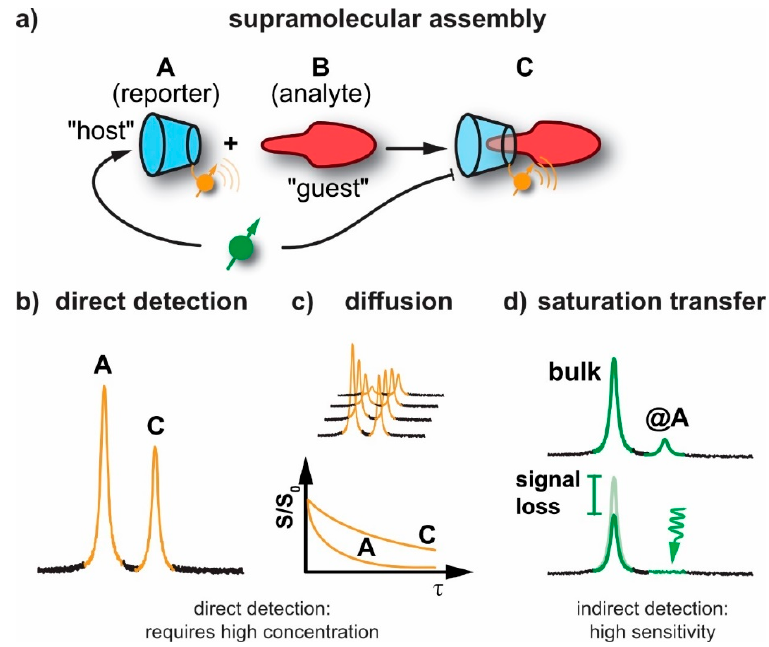
Figure 2. Investigating supramolecular assemblies with NMR. ( a ) Example for a spin label as part of one of the constituents (orange) or a spin label from the free bulk solution pool (green) that can access the binding site of constituent A. ( b ) Direct NMR detection of A yields a second peak upon engaging with B to form C. ( c ) Diffusion-weighted NMR indicates a faster signal decay of the free constituent A than of the complex C with increasing diffusion time τ . ( d ) Saturation transfer NMR rely on detecting spins of free guests (green) in the bulk pool after saturating the magnetization of spins that are transiently bound to the cavity of A. On-resonant saturation causes a signal loss of the bulk pool signal. This process is restricted upon formation of the complex C.